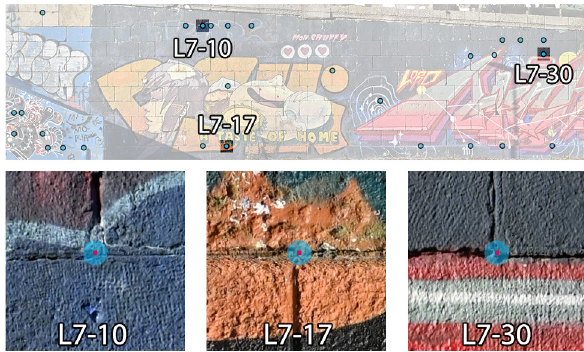
Figure 5 . Three typical GPs out of the thirty that constitute cluster L7 on the left Donaukanal